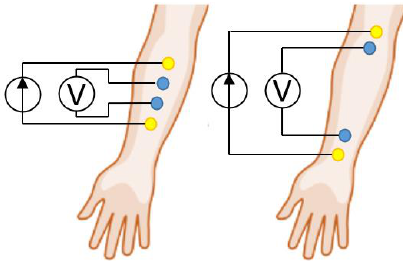
Figure 1. An example of the ES size and location for upper limb EI myography.